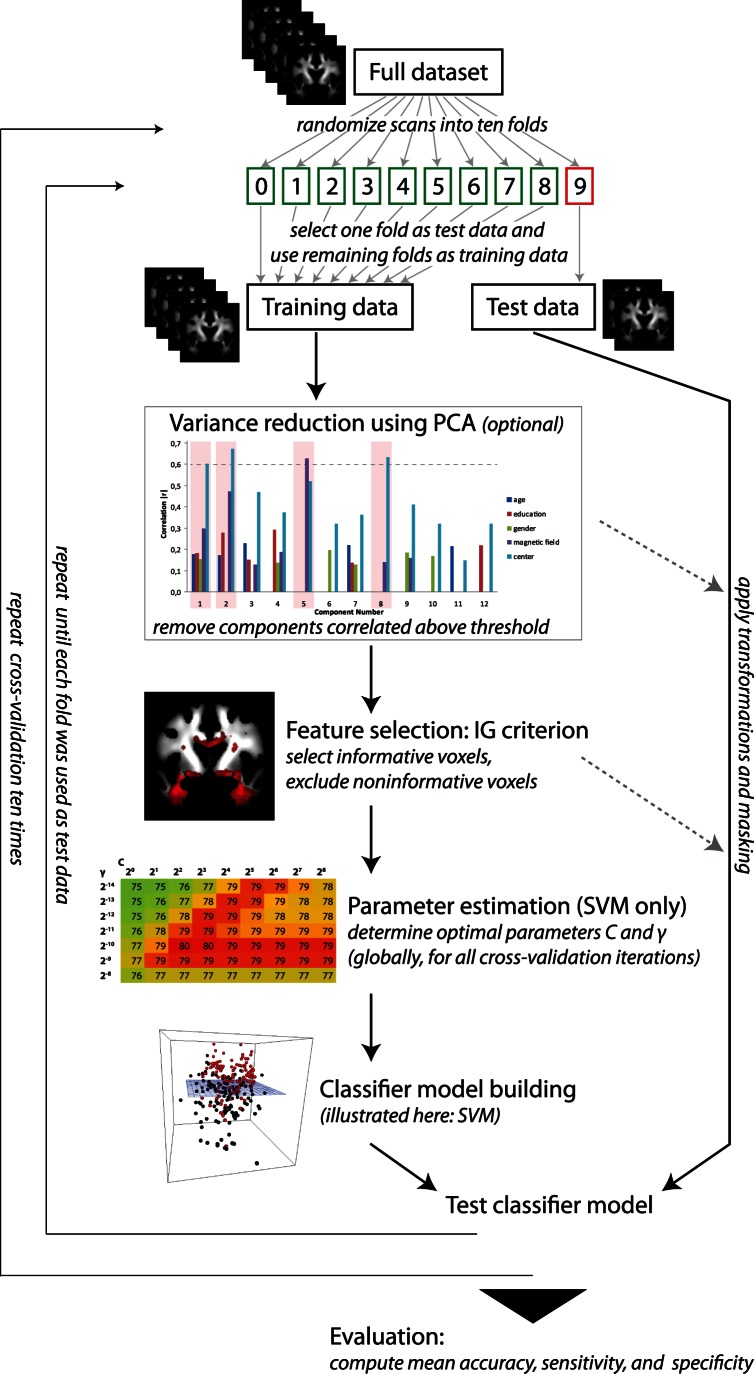
Flow chart of the ML analysis.